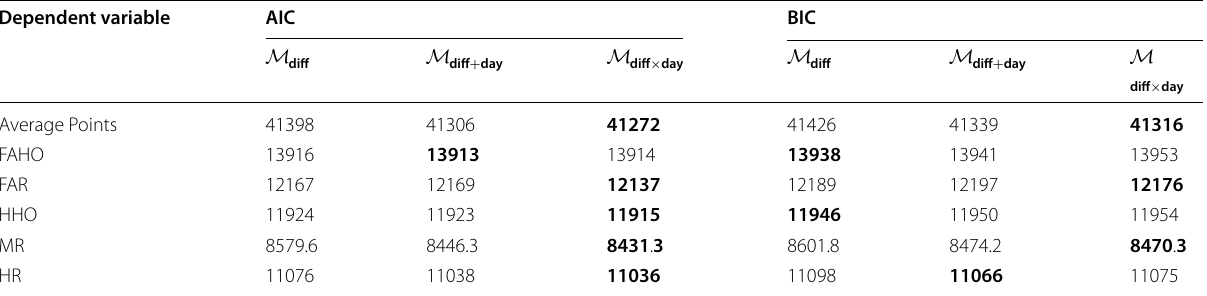
Values in bold indicate the best-fitting model